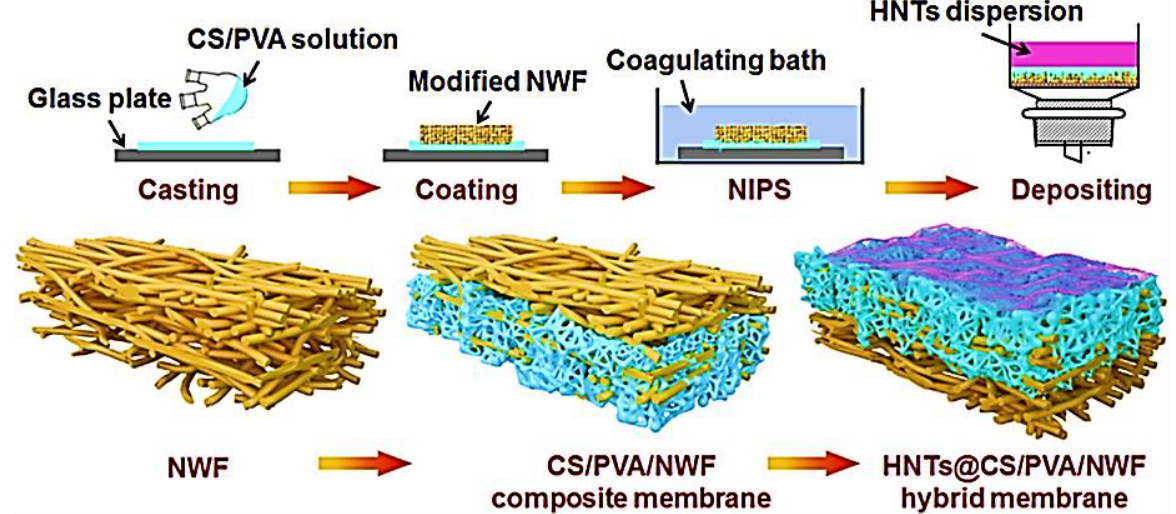
Figure 10. Schematic diagram for fabrication of HNTs@CS/PVA/NWF membranes [197]. NIPS = nonsolvent induced phase separation; NWF = non-woven fabric; CS/PVA/NWF = chitosan/poly(vinyl alcohol)/non-woven fabric; HNTs@CS/PVA/NWF = halloysite nanotubes@chitosan/poly(vinyl alcohol)/non-woven fabric. Reproduced with permission from Elsevier.